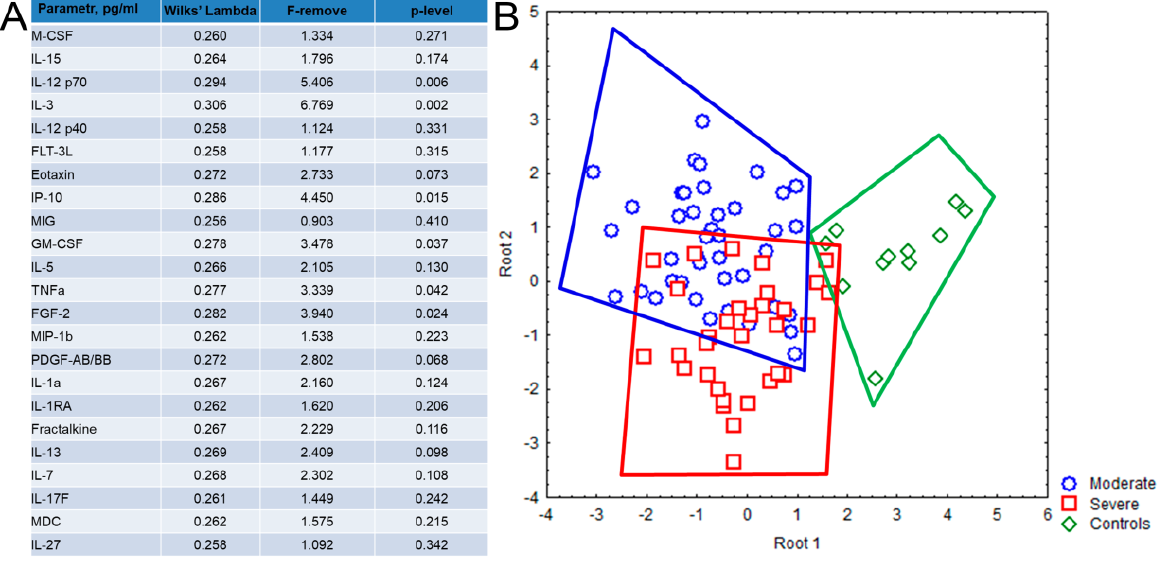
Figure 2. Discriminant analysis based on the cytokine levels in plasma samples, obtained from patients with COVID-19 and healthy donors, consisted of 23 steps and 23 variants in the model with Wilks’ lambda = 0.249, approx. F (46.118) = 2.572, p < 0.001. ( A ) The list of 23 cytokines with high grouping and discriminant value included in the model. ( B ) Dot plot shows the clusters formed by the patients with moderate (blue color) and severe (red color) disease and healthy donors (green color). Each dot represents one person.